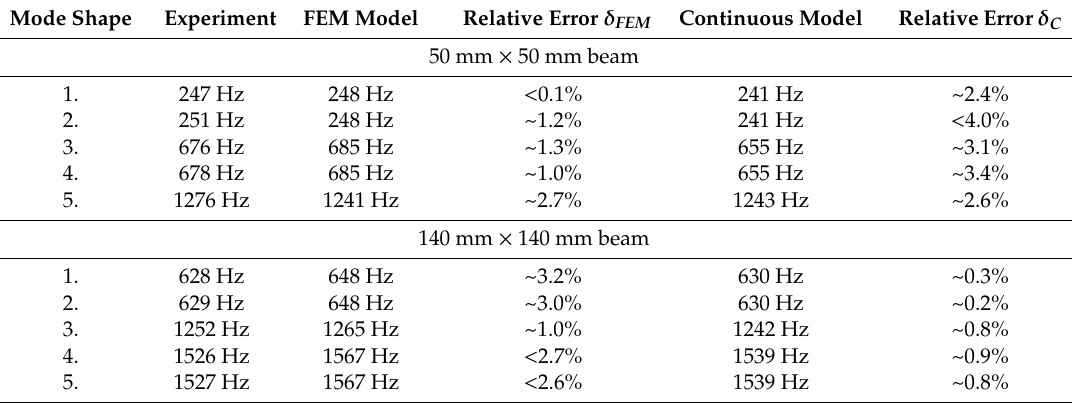
Table 6. Comparison of calculated and experimentally determined natural frequencies for 50 mm × 50 mm and 140 mm × 140 mm beams.